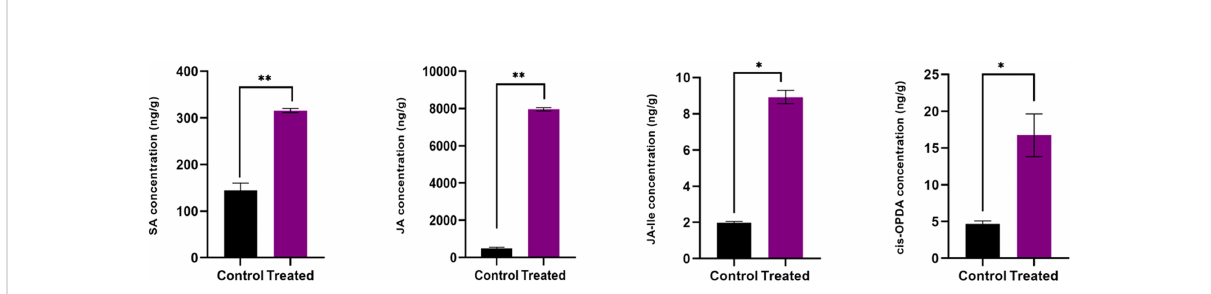
FIGURE 3 Endogenous level of defense phytohormones SA, JA, JA-Ile and cis-OPDA, in P. indica colonized and non-colonized plants. Samples are taken 60th DAI. Hormone quanti fi cation was carried out on the basis of peak area ratio with the hormone standards using LC/MS. Each value is the mean ± SE of three biological replicates. According to student t - test, asterisks indicate signi fi cance at ** P < 0.01 and * P <